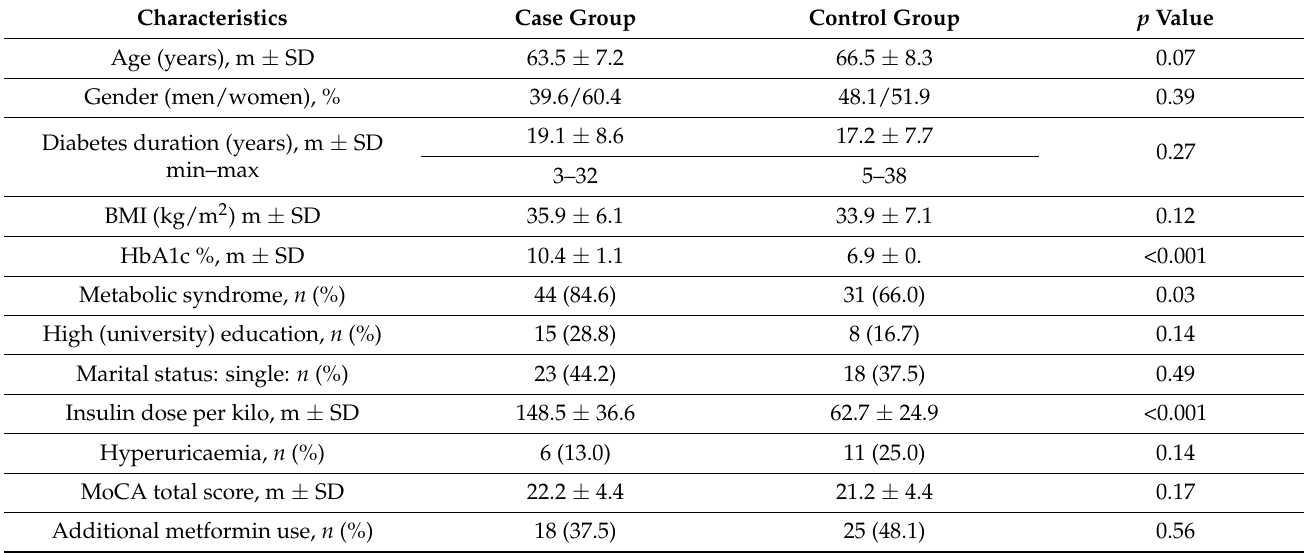
Table 1. Clinical characteristics of participants and the control